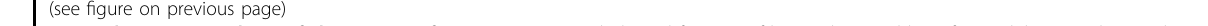
Fig. 5 Phenotypic analyses of chromosome fusion mice. a Morphological features of liver, spleen and lung from adult WT and 25A (Chr15-17 fusion) homozygous mice. Scale bar: 300 mm. b – d Relative organ weight to body weight of liver ( b ), spleen ( c ) and lung ( d ) in 8 weeks WT and Chr15-17 fusion homozygous mice. (mean ± SD, two-tailed Student ’ s t -test, n = 3). e HE staining of liver, spleen and lung from 8 weeks WT and Chr15-17 fusion homozygous mice. Scale bar: 50 μ m. f Chromosome FISH for Chr15 (red) and Chr17 (green) in the cells of liver (left), spleen (middle) and lung (right) from WT and Chr15-17 fusion homozygous mice. The nuclei were stained with DAPI (gray). Scale bar: 2.5 μ m. g Quanti fi cation of relative distance between Chr15 and Chr17 in the cells of the corresponding organs of WT and Chr15-17 fusion homozygous mice. (two-tailed Student ’ s t -test, n = 118, 120, 102, 102, 104 and 104 chromosomes, respectively.) h Quanti fi cation of relative distance of Chr15 and Chr17 to the nucleus center in the cells of the corresponding organs of WT and Chr15-17 fusion homozygous mice. (two-tailed Student ’ s t -test, n = 118, 120, 102, 102, 104 and 104 chromosomes, respectively.) i Serum biochemical test of WT, Chr15-17 fusion heterozygous and homozygous mice. (mean ± SD, n = 5, 3, 3 mice,